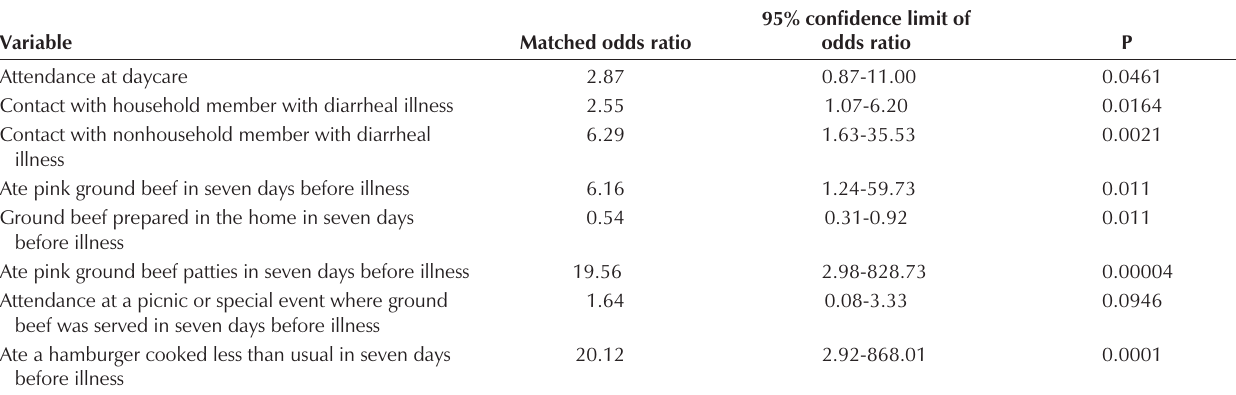
Variables unconditionally associated with case status (P<0.10)